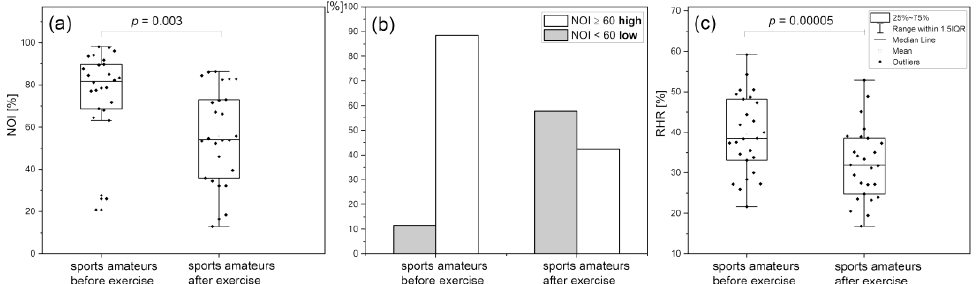
Figure 9. Comparison of NOI ( a , b ) and RHR ( c ) parameters in a group of amateur runners before and after strenuous exercise; the p -values were calculated by the Wilcoxon signed ranks test ( a ) or the paired sample t -test ( c ) [45]. Reproduced from: Chudzik, M.; Cender, A.; Mordaka, R.; Zielinski, J.; Katarzynska, J.; Marcinek, A.; Gebicki, J. Chronic fatigue as-sociated with post-COVID syndrome versus transient fatigue caused by high-intensity exercise: are they com-parable in terms of vascular